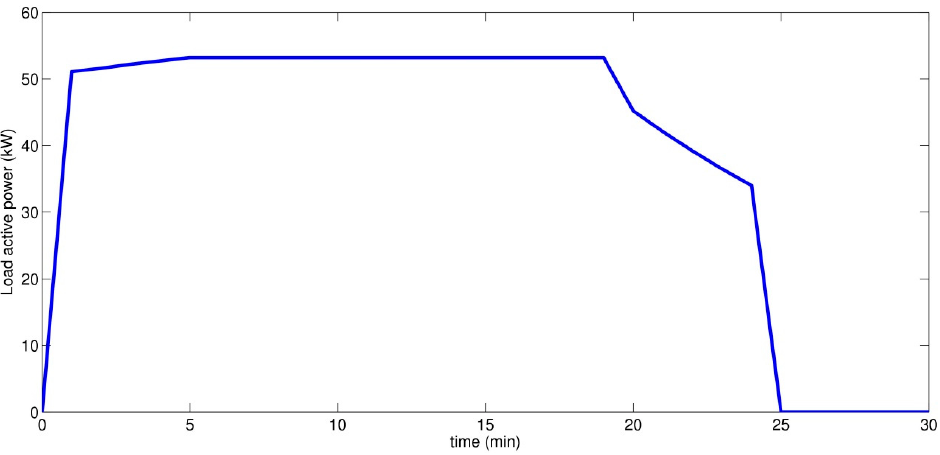
Figure 14. Load active power vs. time for one EV charging cycle.